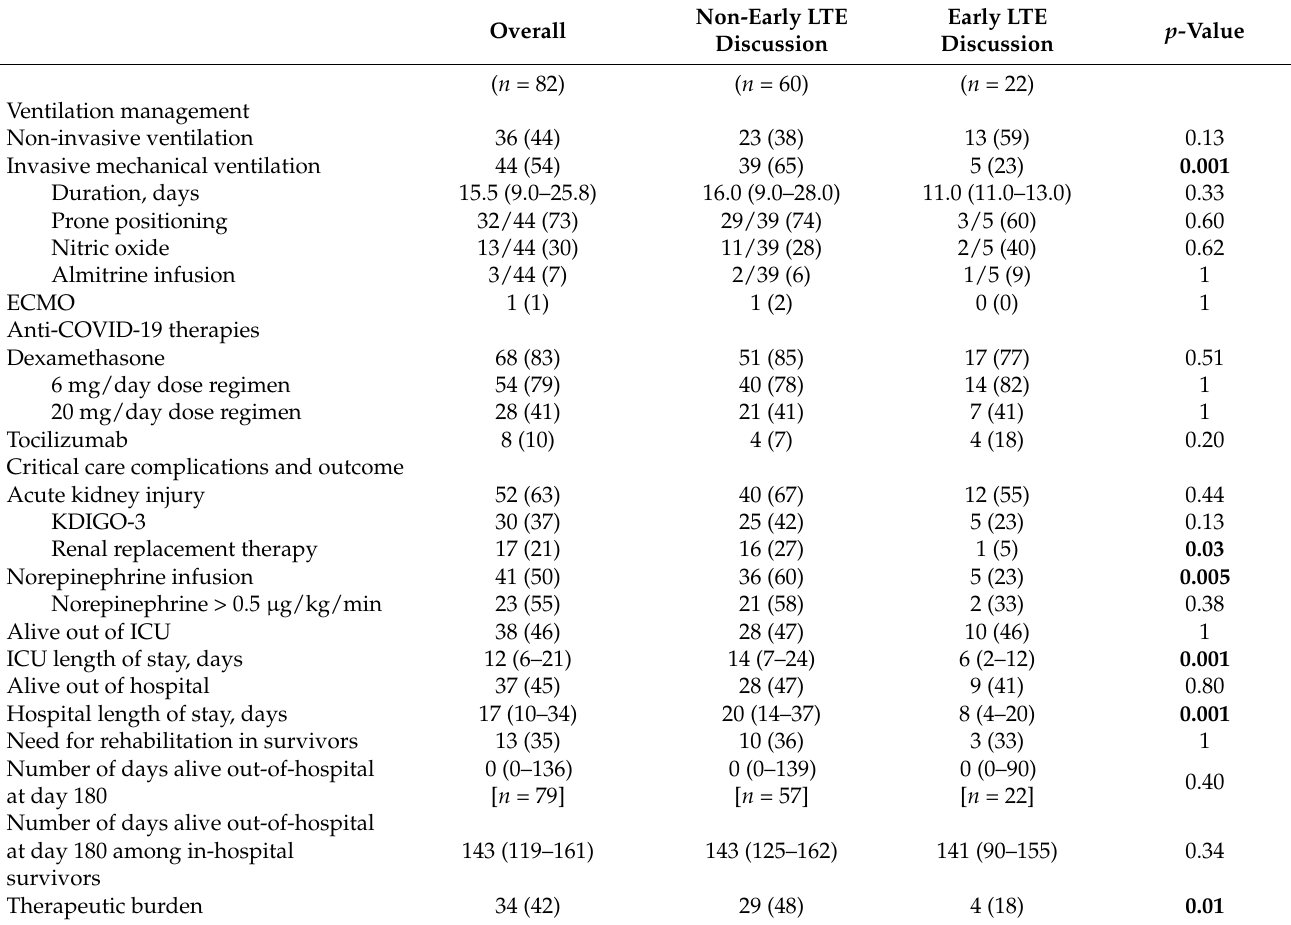
Table 2. Management and outcome in 82 critically ill COVID-19 elderly patients in relation to early versus non-early discussion of limitation of therapeutic